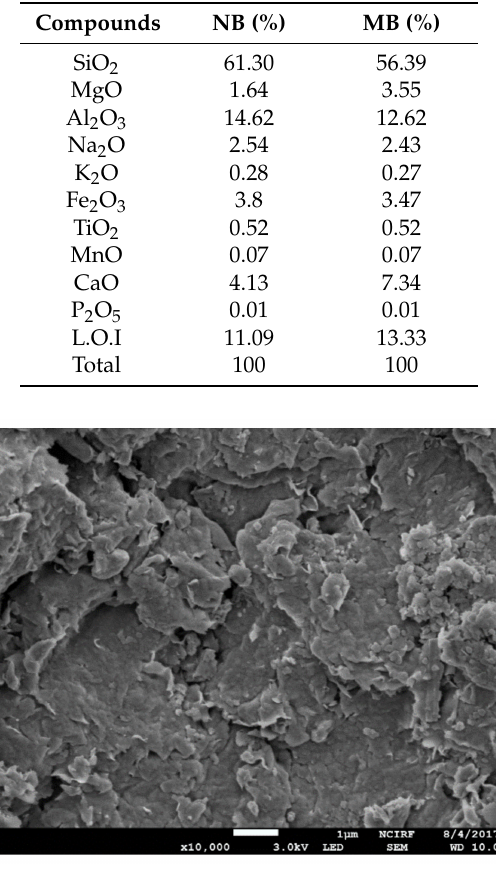
Figure 1. SEM micrographic images of